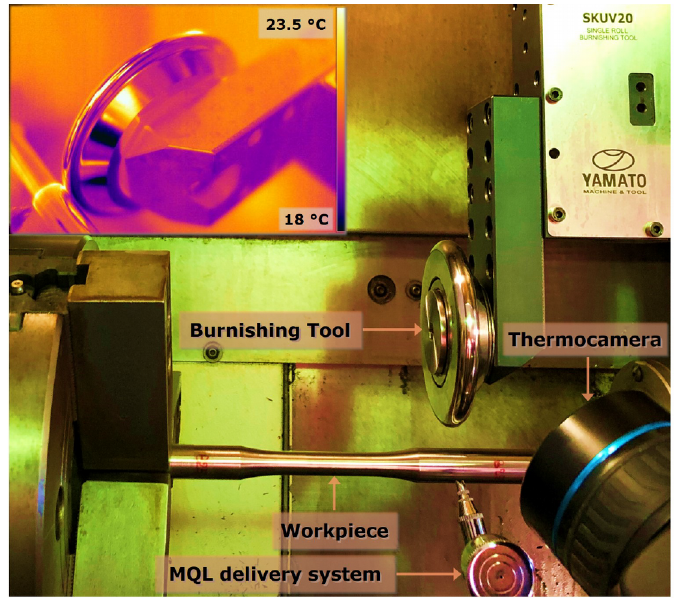
Figure 1. Experimental set-up for burnishing tests (Sanguedolce et al.,